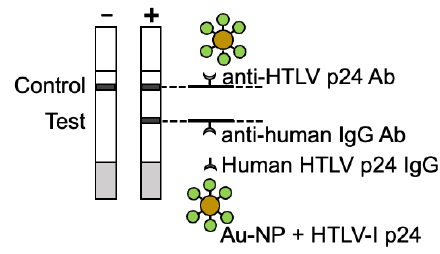
Figure 4. Schematic of the rapid screening test for HTLV-I. The test uses HTLV-I p24 antigen conju- gated to gold nanoparticles and an anti-human IgG antibody immobilized to a nitrocellulose strip at the “Test” area to detect human HTLV-I p24-specific IgG antibodies via immunochromatography. An HTLV-I p24-specific antibody is also immobilized to the nitrocellulose strip at the “Control” area to assess flow of the patient sample and manufacturing of the product.